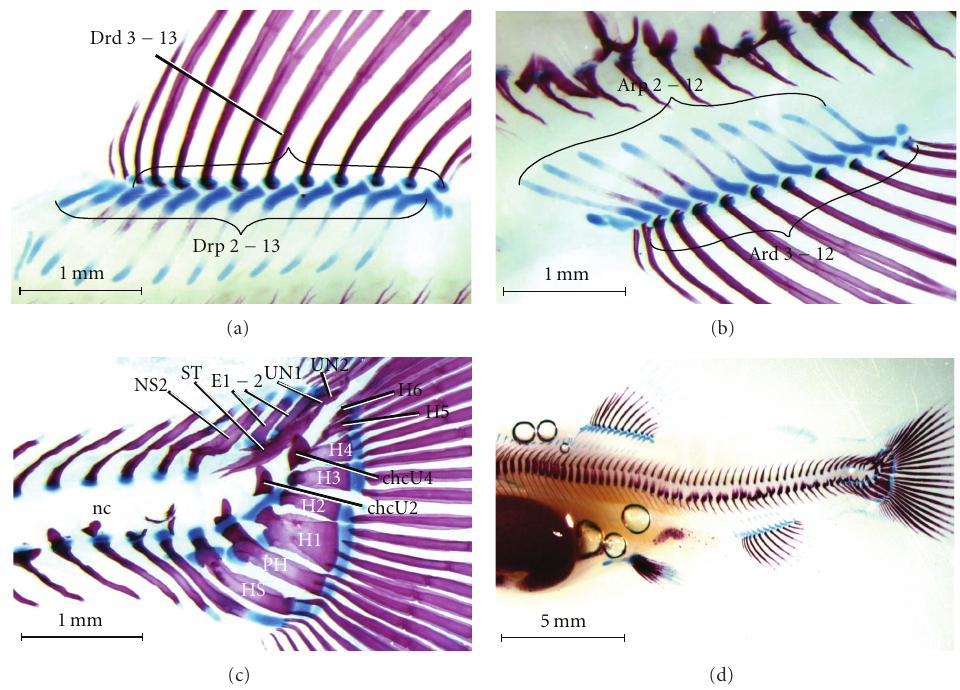
Figure 1: Anatomy of the postcranial skeleton in juvenile Salvelinus alpinus (d). Details of the dorsal (a), anal (b) and caudal fins (c). Cartilages are stained with Alcian blue and bones with Alizarin red-S. Individual in (a)–(c) is 78dph old ( L S = 25 . 72 mm) and in (d) is 64 dph old ( L S = 28 . 39